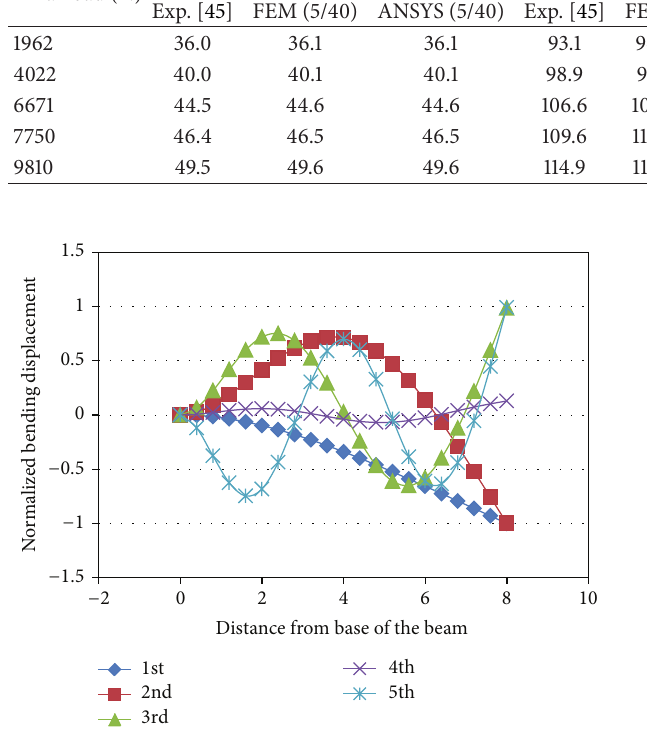
Figure 8: Variation of critical buckling compressive force with end moment. Table 8: Comparison between the experimental and FEM natural frequencies versus axial load, for an aluminum fixed-fixed beam. Axial load (N)